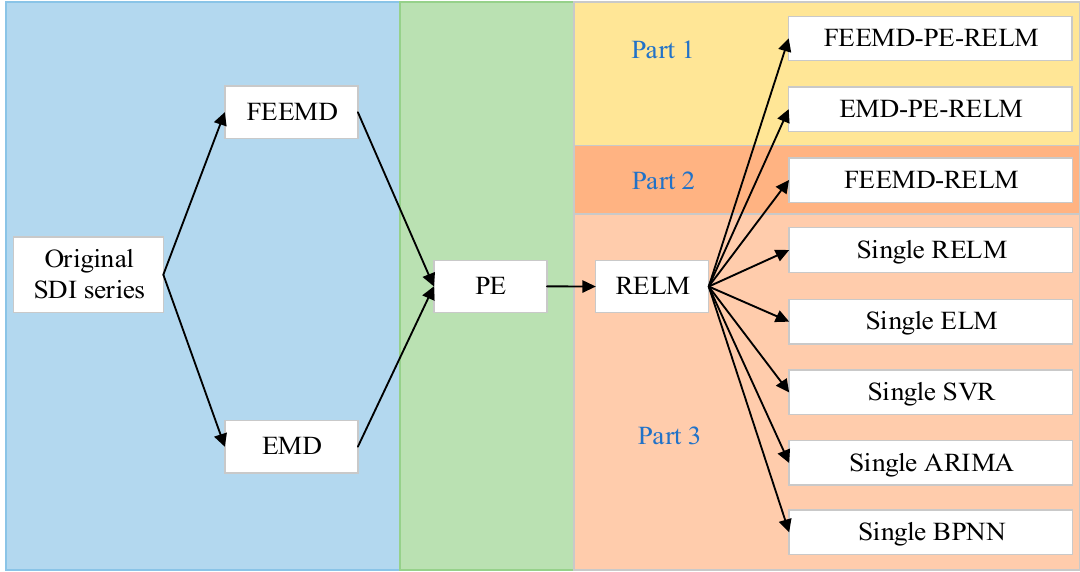
Figure 8. Framework of the model comparisons.